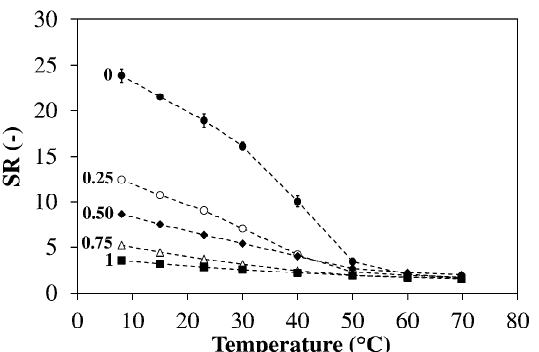
Figure 9. Temperature dependence of the swelling ratio in NaCl 0.1 M. Hydrogels prepared using q = 0.80, f JD400 = 0.40 and the reported values of f ODA . Each datum represents the average of four replicates.